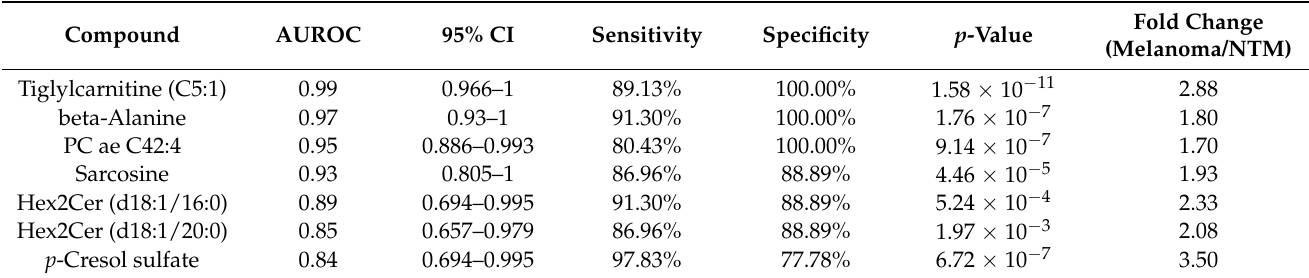
Table 1. Plasma biomarker candidates for melanoma. Potential biomarker candidates were selected according to false discovery rate (FDR)-corrected p -value < 0.05 and fold change > 1.5. Biomarker performance was evaluated using the area under the receiver operating characteristic curve (AUROC), sensitivity (true positive rate), and specificity (true negative rate)